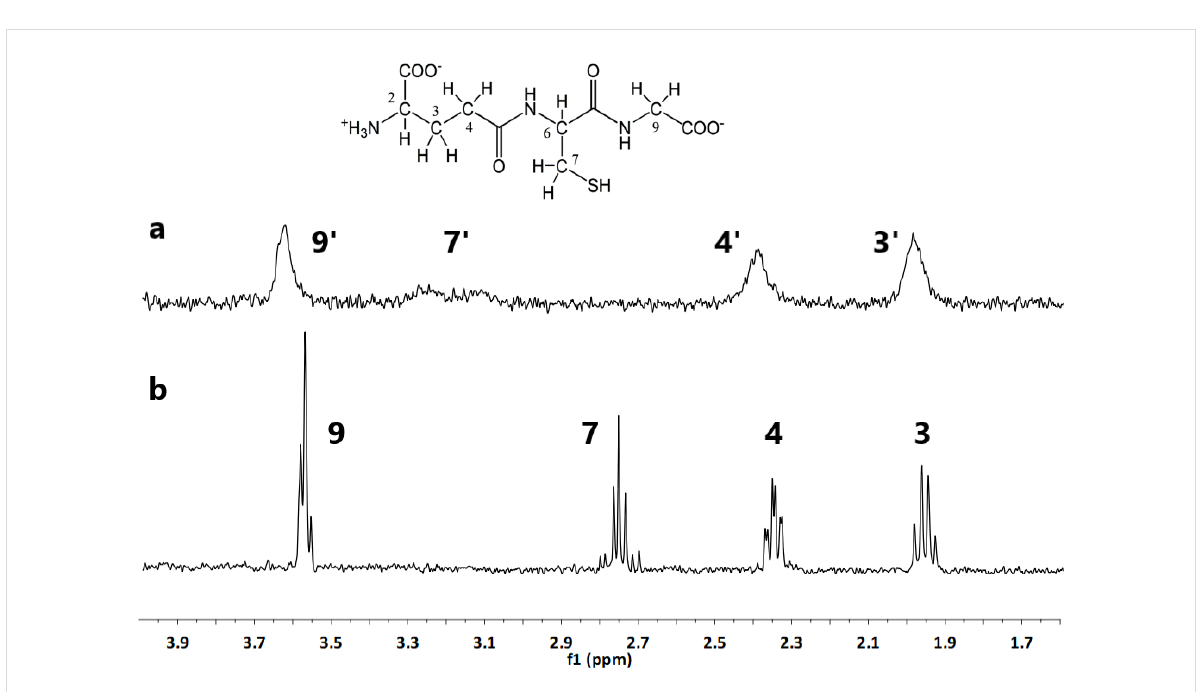
Figure 8: 1 H NMR spectra of (a) GSH-coated AgNPs formed during the interaction between AgNO 3 and GSH and (b) free GSH. Both spectra are ob- tained in 25 mM phosphate buffer (pH 6.8). The structure of reduced GSH is shown above panel (a).